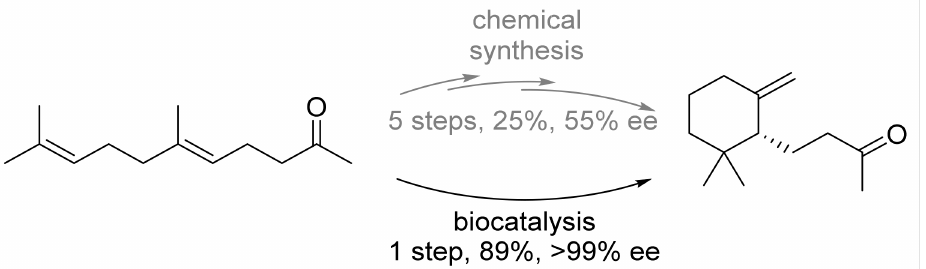
Figure 8. Cyclisation of the ketone to the terpenoid within a single biocatalytic step in contrast to a five-step synthesis